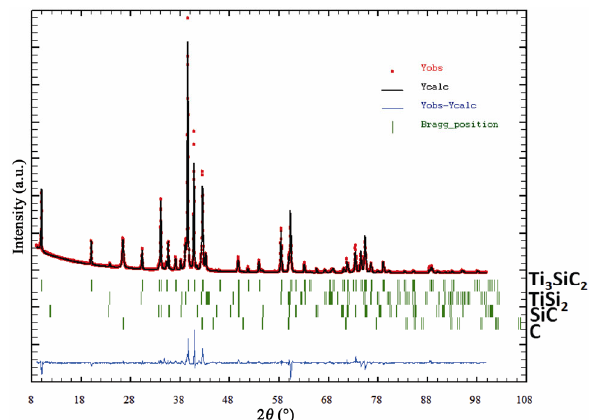
Fig. 7 Example of Fullprof program fit of Ti/SiC sample after SPS sintering at 1400 ℃ for 20 min ( χ 2 =